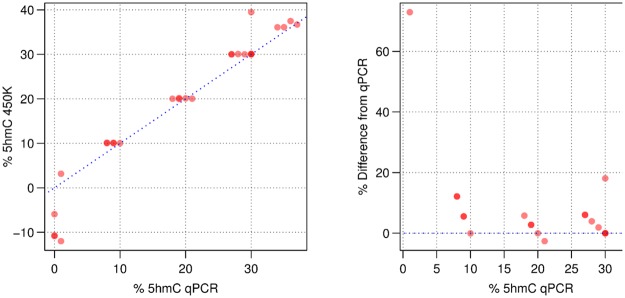
Comparison between oxBS arrays and qPCR.Right: Correlation between 5hmC detected by qPCR vs array probes. Left: Discrepancy between qPCR and arrays quantified as percentage difference relative to qPCR (See also S1 Document). Data points having the same coordinates appear in darker red.